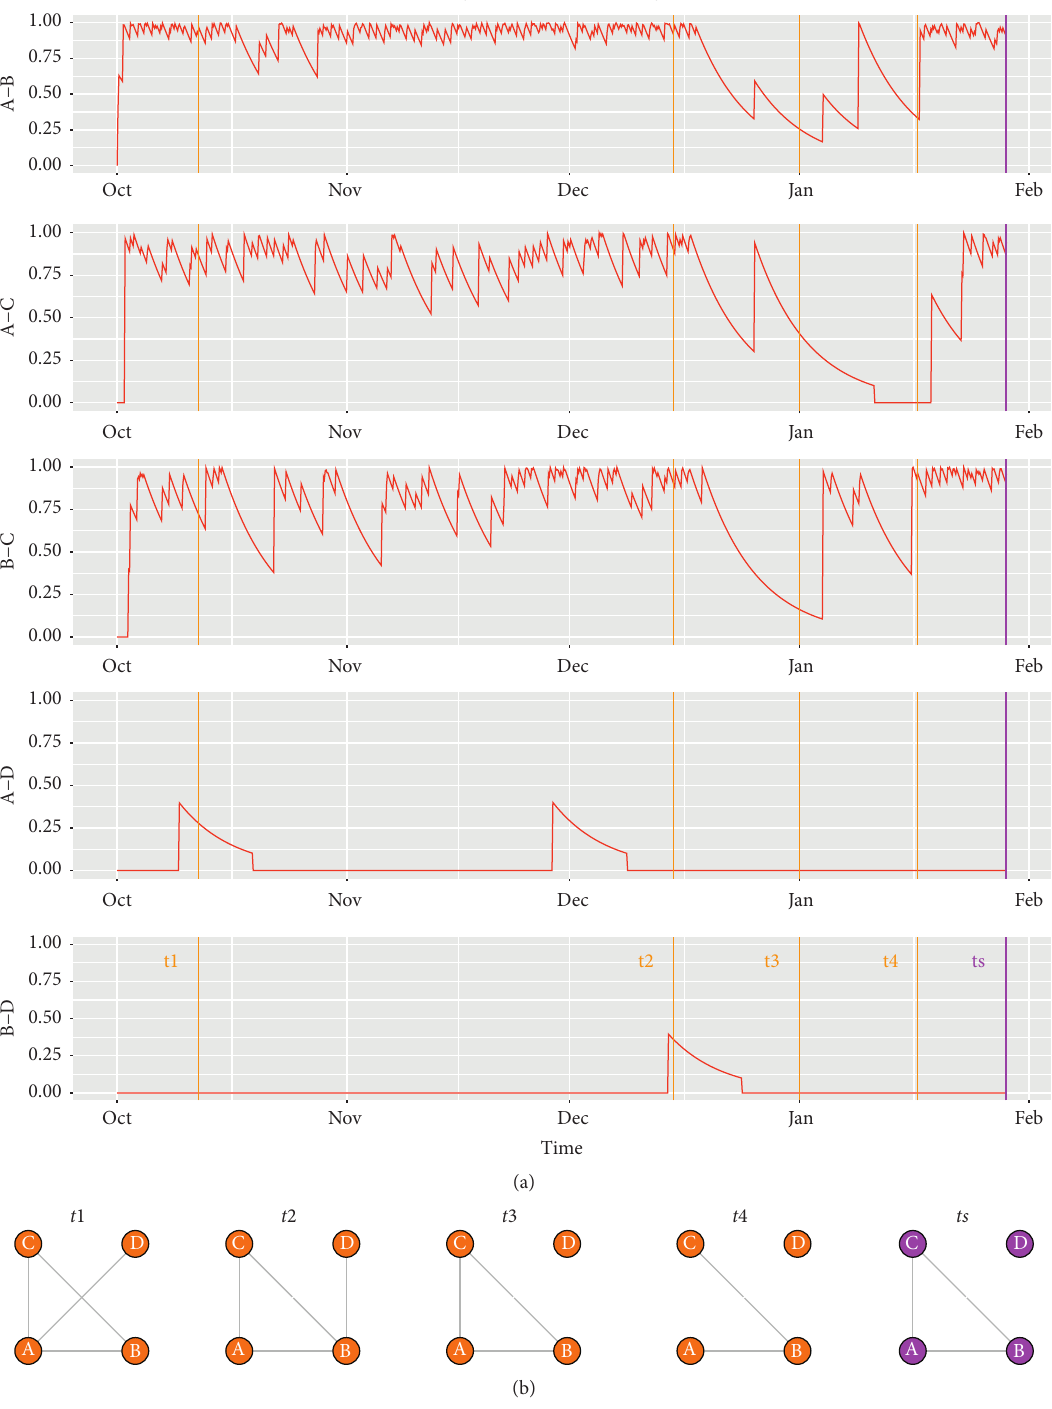
– t and at the survey time t s 1 4